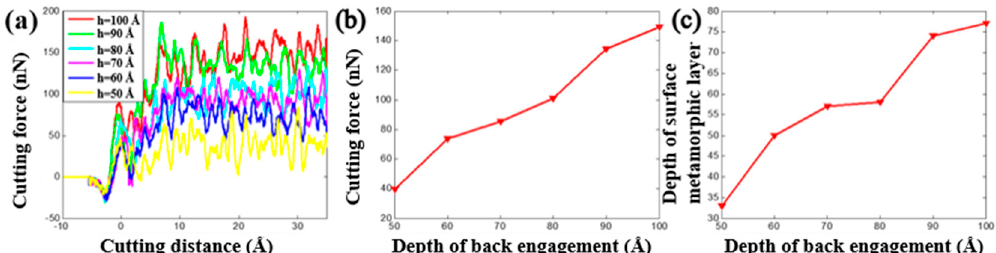
Figure 5. The cutting force and depth of surface metamorphic layer obtained from QC by varying the depth of back-engagement. ( a ) Cutting force vs. the cutting distance under different back-engagement h; ( b ) evolution of the average cutting force when varying the depth of back-engagement and ( c ) evolution of the depth of the surface metamorphic layer when varying the depth of back-engagement.